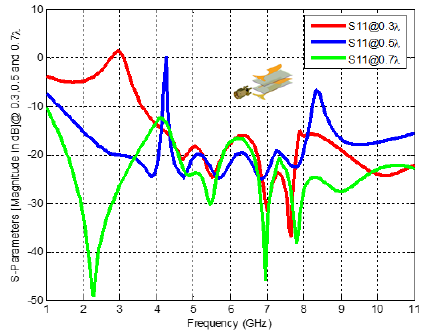
FIGURE 9. Reflection coefficient of the antenna with different values of inter-element distance (0.3 λ , 0.5 λ and 0.7 λ